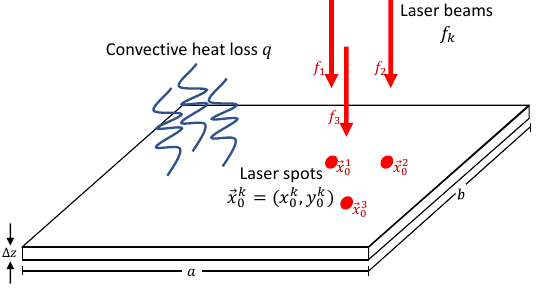
Figure 1. Multi-beam laser heating scheme. The sheet surface is heated by a set of laser beams f 1 , f 2 , . . . and cooled down due to natural convection q